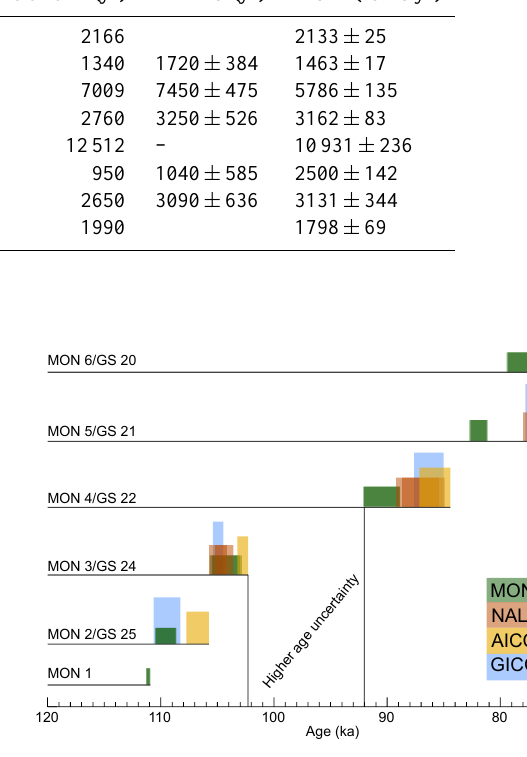
at the MIS 5e/d transition (Chapman and Shackleton,